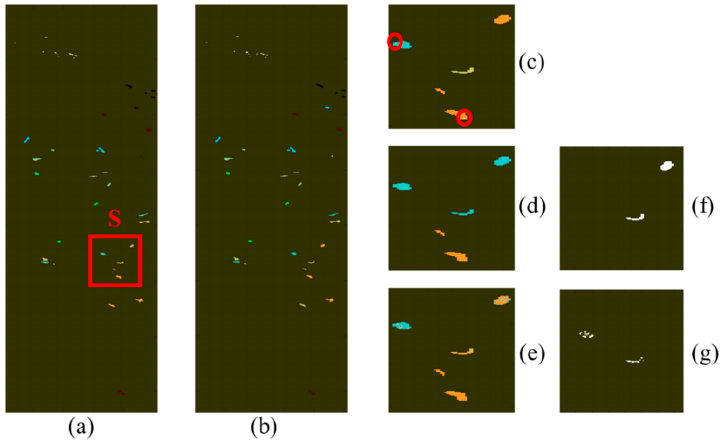
Figure 8. Classification result of BOT with three training samples per class (OA = 87.1%). ( a ) The classification result of BOT. ( b ) The ground truth of BOT. ( c ) The randomly selected training samples (marked with red circles) in region S. ( d ) The visualization of CASD’s effect. The labels of test samples are decided by the labeled samples nearby. Several ground blocks have been misclassified. ( e ) The final classification result of the CASD assisted PCSSR algorithm. ( f ) The classification errors in ( d , g ). The classification errors in ( e ).